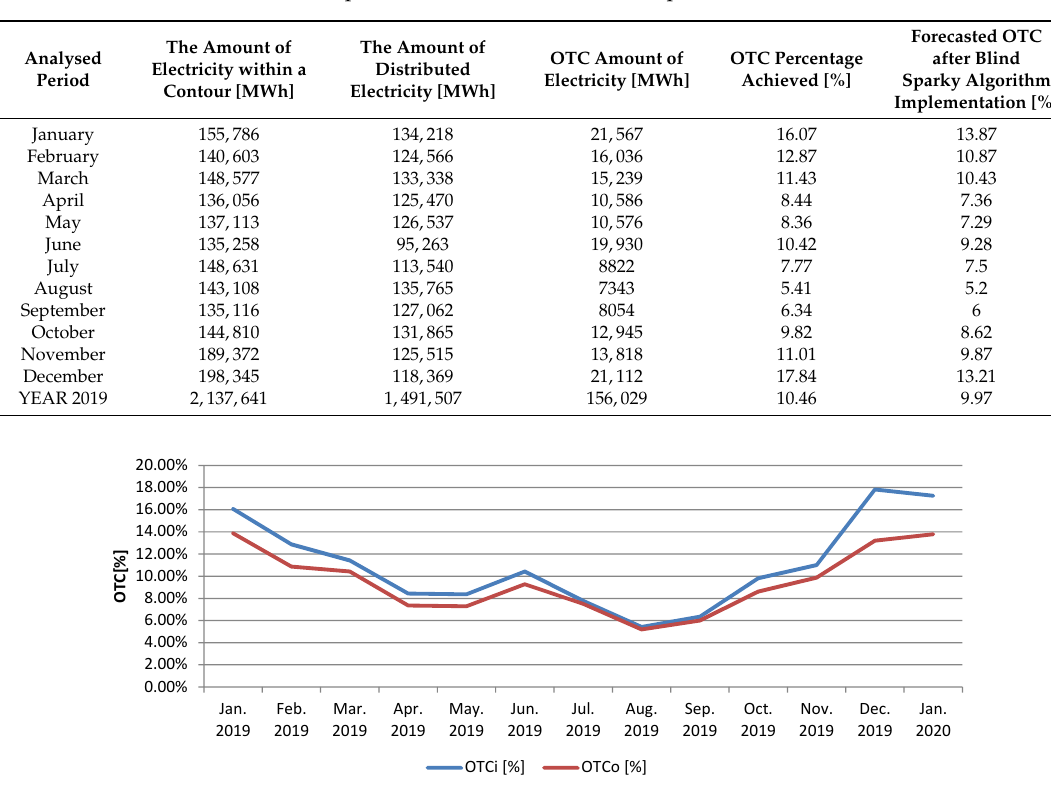
Table 5. Experimental measured data and optimized results.